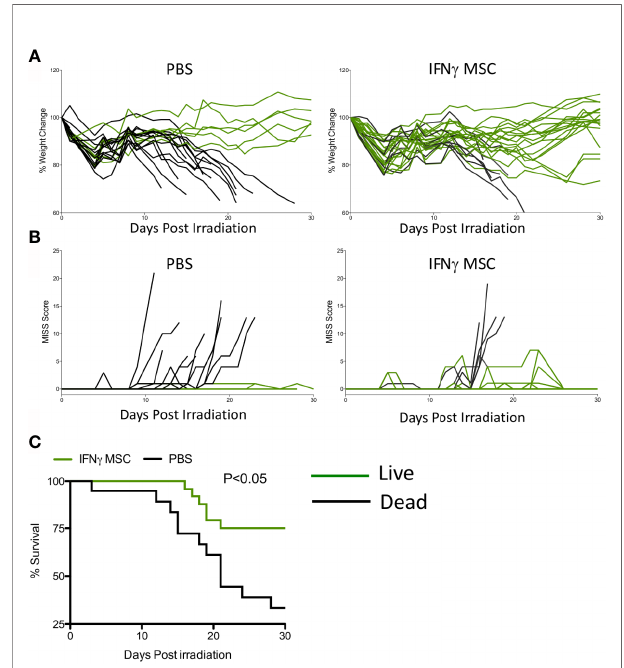
FIGURE 3 | IFN g licensed allogeneic MSCs mitigate ARS lethality. Balb/c mice were subjected to 4 + 4Gy irradiation. 24 hours later, IFN g licensed MSCs (20ng/ml for 48 hours) were injected intraperitoneally into animals with a dose of 10 7 cells/animal. Subsequently, a second dose of 10 7 cells/animal was given on day 8. Controls received only PBS. (A) % change in body weight and (B) total MISS score were followed longitudinally between control (n=20 animals) and treatment groups (n=25 animals). Green lines represent mice that survived on day 30 and black lines represent dead animals. (C) Kaplan Meier survival curves were plotted as cumulative data from two independent groups. Cumulative of two independent experiments is